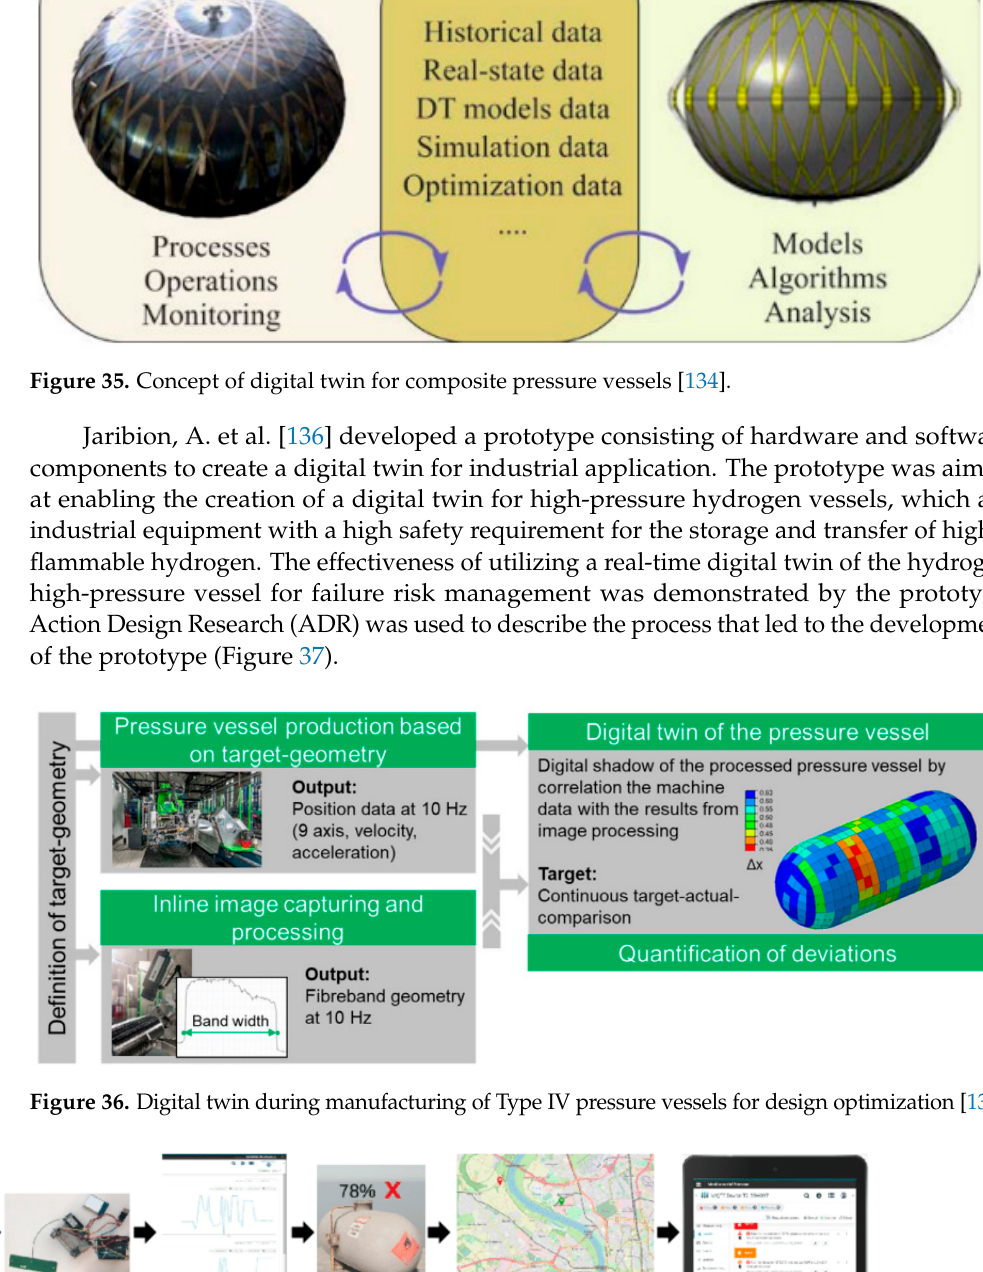
Figure 34. Flow chart of the adaptive genetic algorithm [116].